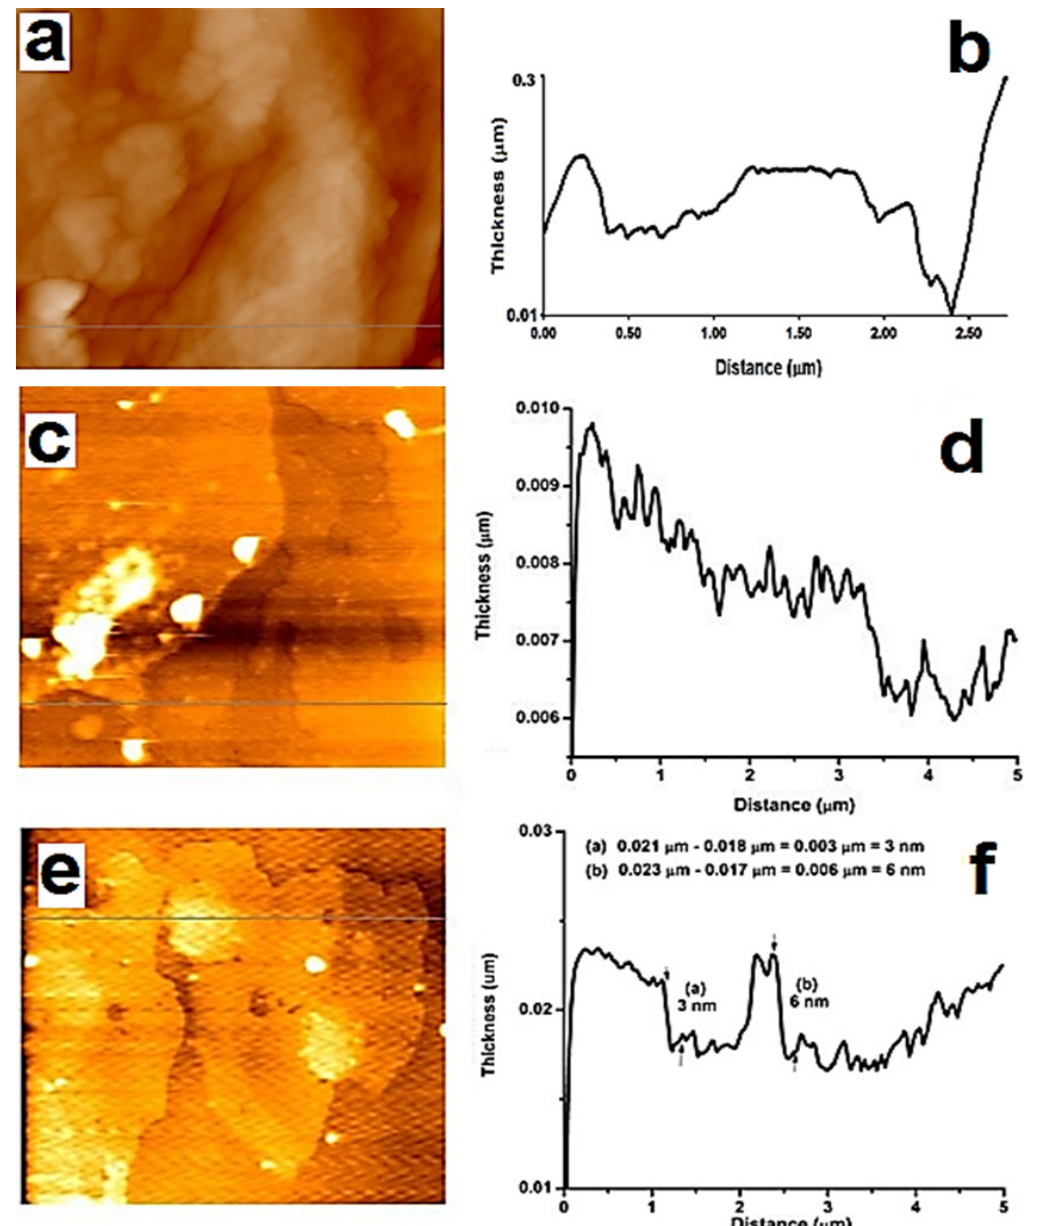
( b ) topography of chitosan; ( c ) AFM image of GEO; ( d ) topography of GEO; ( e )